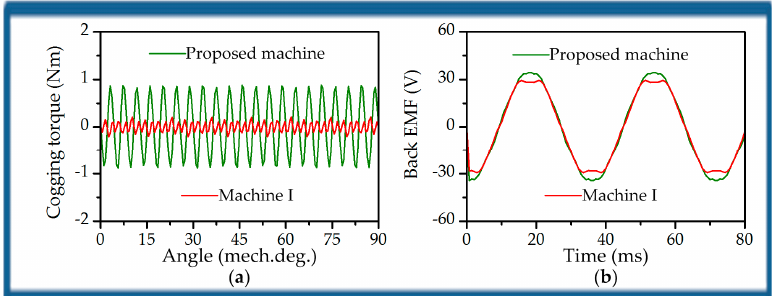
Figure 17. Performance comparison: ( a ) Cogging torque; and, ( b ) Phase back EMF.